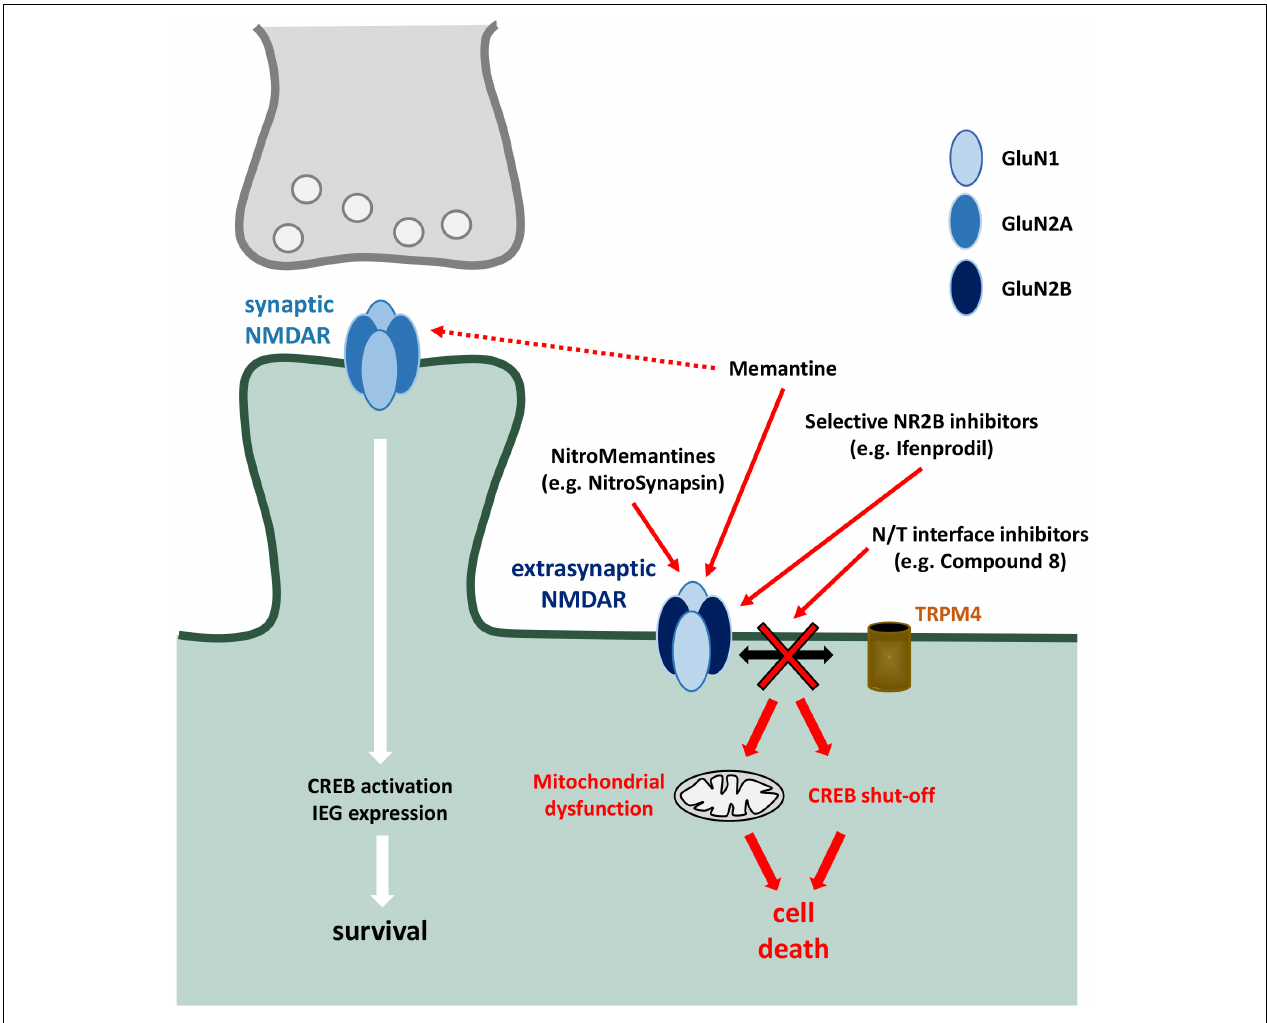
FIGURE 2 | Targetted pharmacological inhibition of extrasynaptic NMDARs. Preferential targetting of extrasynaptic NMDARs is a strategy to inhibit downstream toxic events (including mitochondrial dysfunction, activation of death signalling cascades, CREB dephosphorylation and shut-off, and structural damage), whilst sparing protective mechanisms associated with synaptic NMDAR activity [such as CREB activation and expression of neuroprotective immediate early genes (IEG)]. Memantine shows a preferential inhibitory effect of extrasynaptic NMDARs, which has been harnessed and developed with the NitroMemantine drug series. Selective NR2B inhibitors aim to take advantage of preferential NR2B association within extrasynaptic NMDAR heterotetramers. NDMAR-TRPM4 (N/T) interface inhibitors target the death-promoting complex formed between NMDAR and TRPM4 which, due to the absence of TRPM4 in synapses, mediate the neurodegenerative effects of extrasynaptic NMDAR